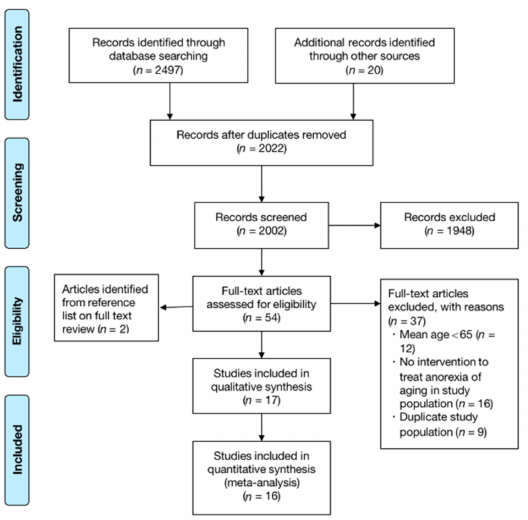
Figure 2. Flow diagram for screening and eligibility of studies for